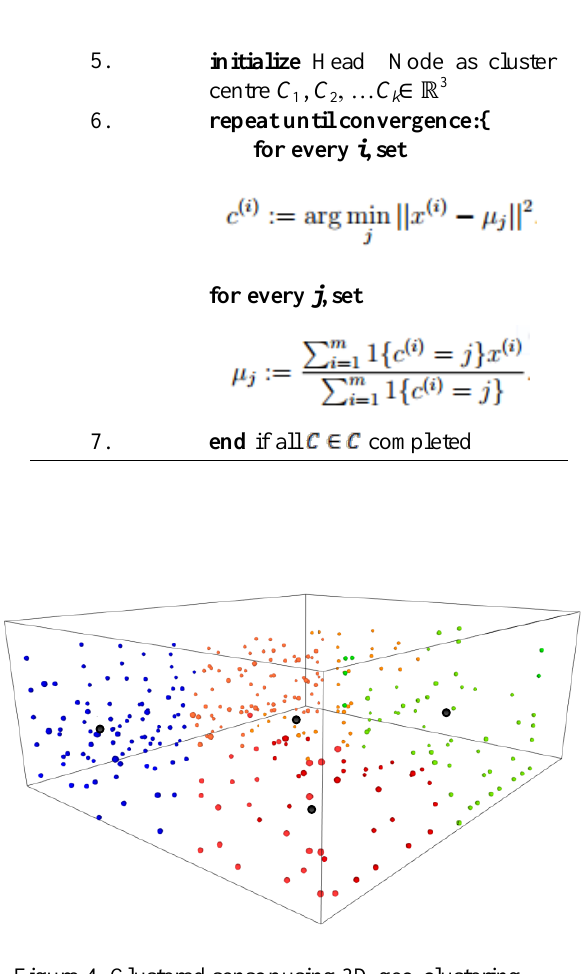
Figure 4. Clustered sensor using 3D